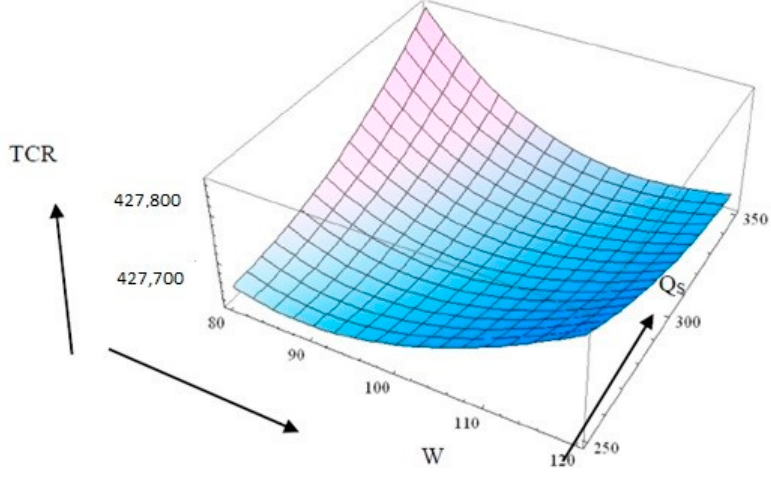
J. Risk Financial Manag. 2021 , 14 , x FOR PEER REVIEW Figure 7. Convexity of TCR relating to W and Q s . Figure 7. Convexity of TCR relating to W and Q s .